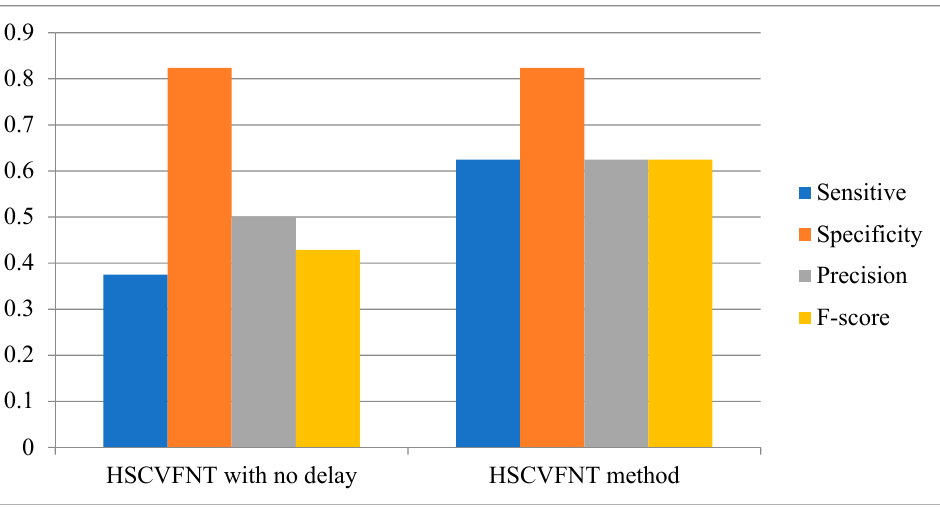
Figure 8. Effect of time-delayed factor for IRMA network inference with on dataset.